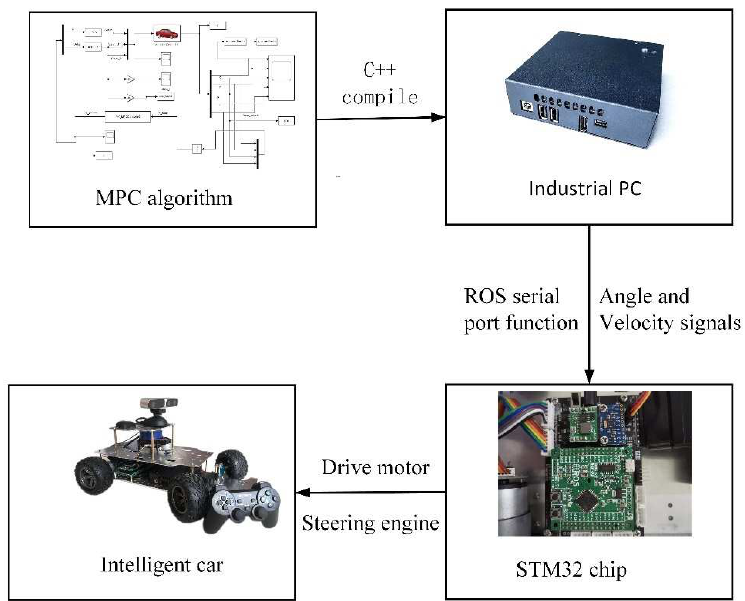
Figure 8. Basic structure of intelligent car parking experiment.